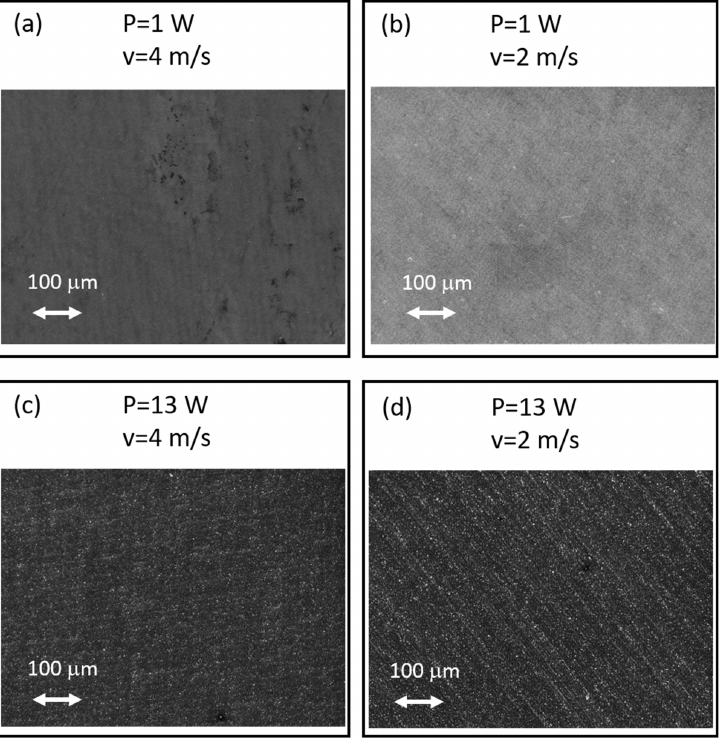
Figure 2. Three-Dimension-profilometry and 2D profile of as it is sample ( a ); P = 1 W, v = 4 m/s ( b ); P = 1 W, v = 2 m/s ( c ); P = 13 W, v = 4 m/s ( d ) and P =13 W, v =2 m/s ( e ).